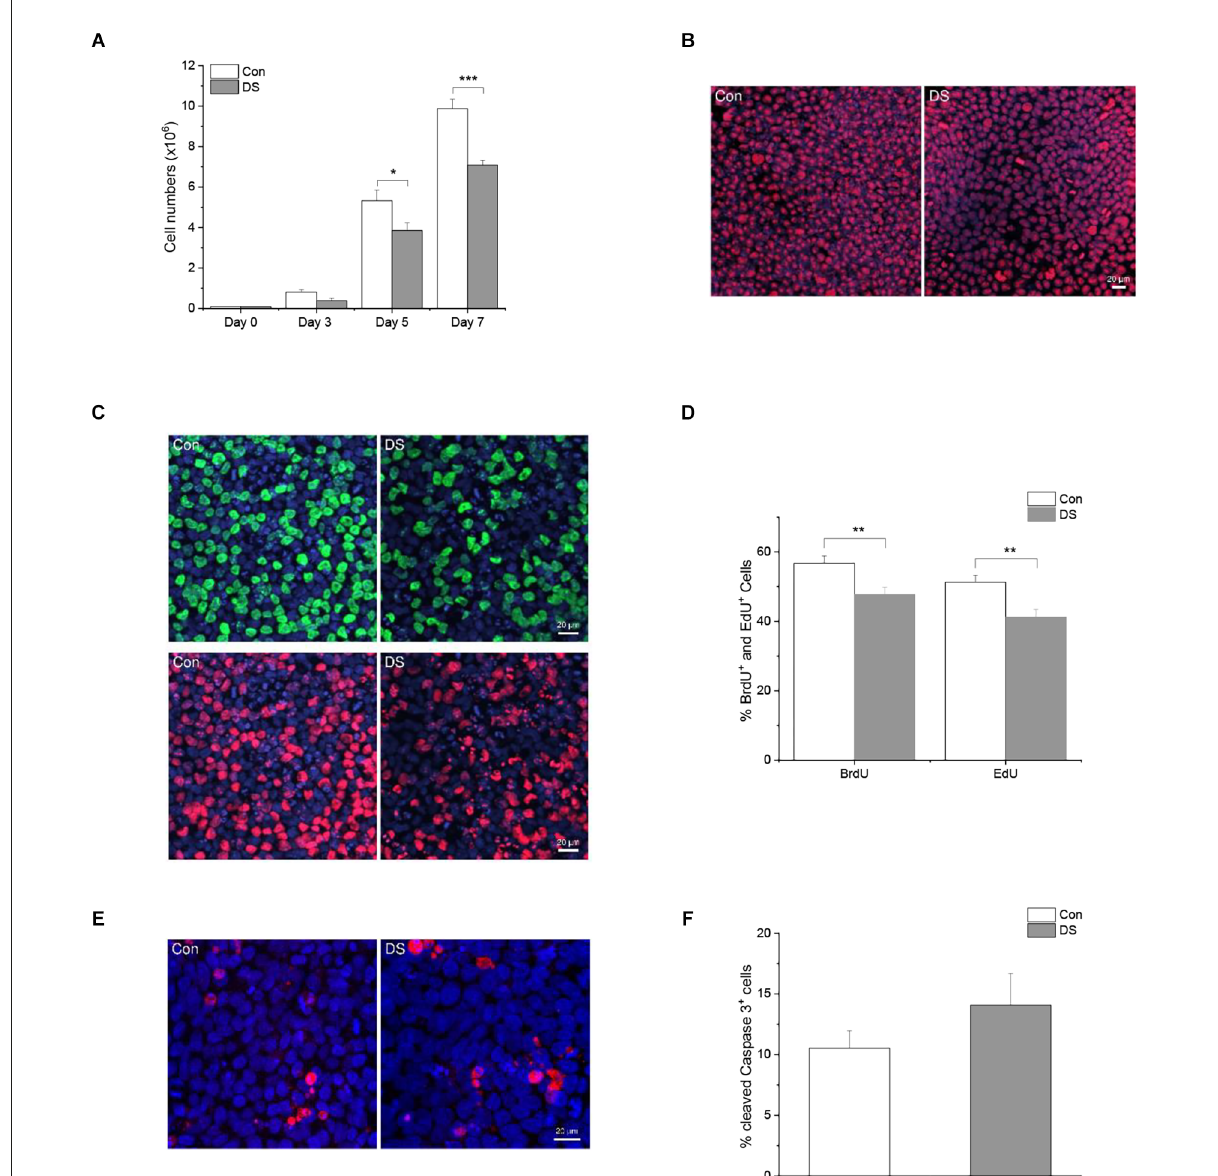
FIGURE2 Decreased cell growth in DS iPS cells. (A) iPSCs were seeded in a 6-well plate with a density of 10 5 live cells/well and total cell numbers were counted after 3, 5, and 7 days in culture. DS iPSCs have a significantly reduced cell number as compared to control iPSCs at day 5 ( n = 12, p < 0.05) and day 7 ( n = 12, p < 0.001). (B) A representative immunostaining of Ki67 in DS and control iPSCs. (C) A representative double labeling of BrdU (green) and EdU (red) in DS and control iPSCs. (D) Immunohistochemical analysis of BrdU + and EdU + cells revealed that DS iPSCs have a significantly decreased number of BrdU + and EdU + cells than control iPSCs ( n = 1,690–1,897 cells, p < 0.01). (E) A representative immunostaining of cleaved caspase 3 in DS and control iPSCs. (F) Immunohistochemical analysis of cleaved caspase 3 revealed a similar percentage of cell death in DS and control iPSCs ( n = 1,045–1,570 cells, p > 0.05). * p < 0.05, ** p < 0.01, and *** p < 0.001 vs.